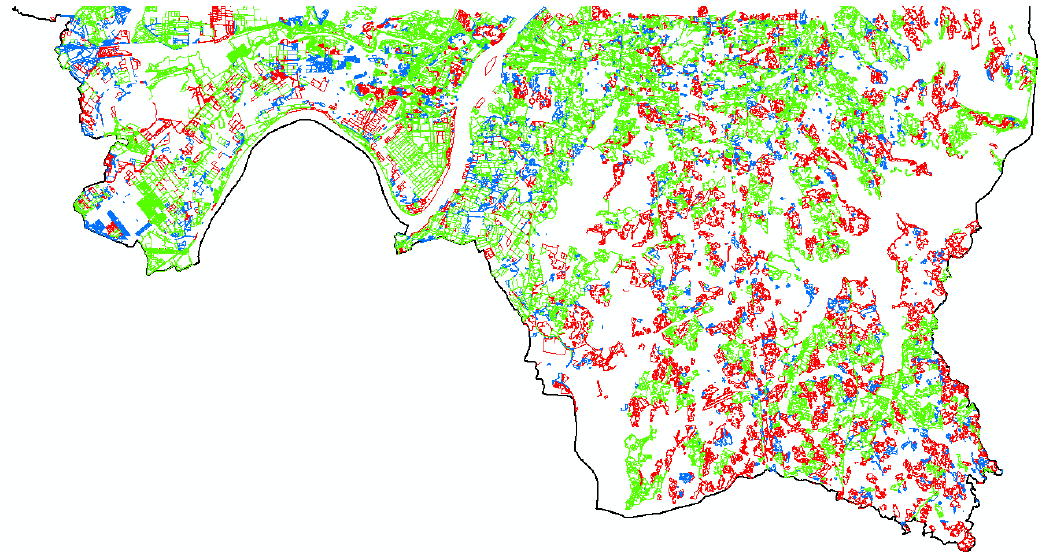
Figure 8. The polygon-based change map, where the white background is unchanged area, green